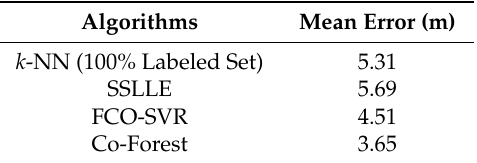
Table 5. The mean error distances of algorithms under adverse